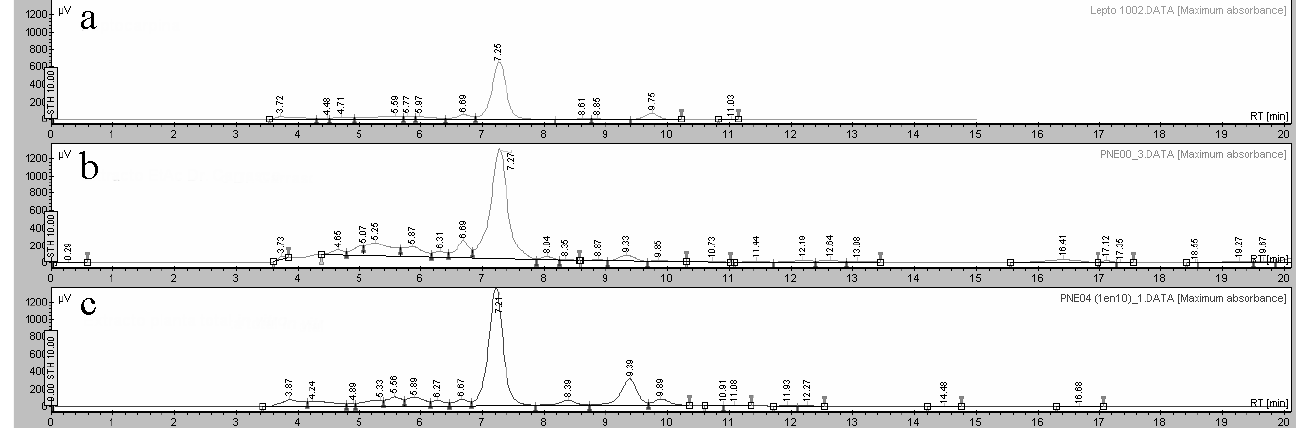
Figure 3. HPLC chromatograms obtained for: ( a ) LTC pure compound; ( b ) extract of L. rivularis plants collected from natural habitat; ( c ) extract of micropropagated explants of L. rivularis. In this work, changes in resazurin absorbance were determined for untreated cells (T0), cells treated with LTC (T1), L. rivularis extract (T2), and DMSO at lethal concentration (positive control).